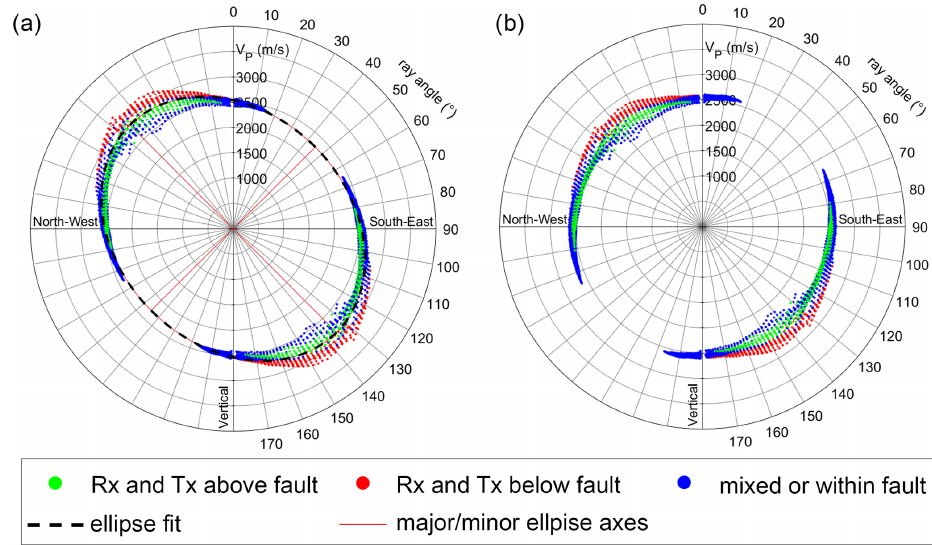
Figure 14. Average V P for all receiver–transmitter (Rx–Tx) pairs within the same plane as the one displayed in Fig. 15. Since V P shows a strong anisotropy (a) , velocities were normalized (b) prior to performing the travel-time inversion.